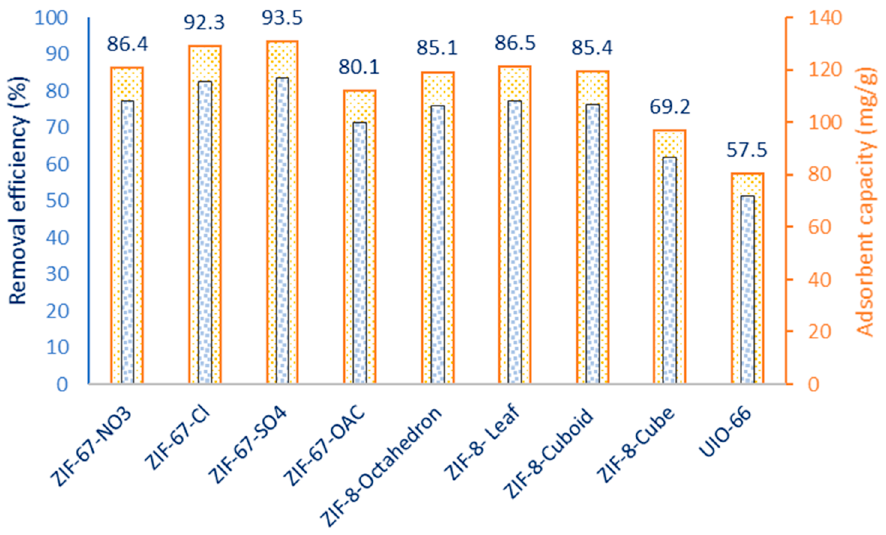
Figure 2. Removal e ffi ciency and adsorption capacity of as-synthesized MOFs for CIP (CIP: 62.5 mg / L, Figure 2. Removal efficiency and adsorption capacity of as-synthesized MOFs for CIP (CIP: 62.5 mg/L, MOF: 0.5 g / L, time: 30 MOF: 0.5 g/L, time: 30 min).